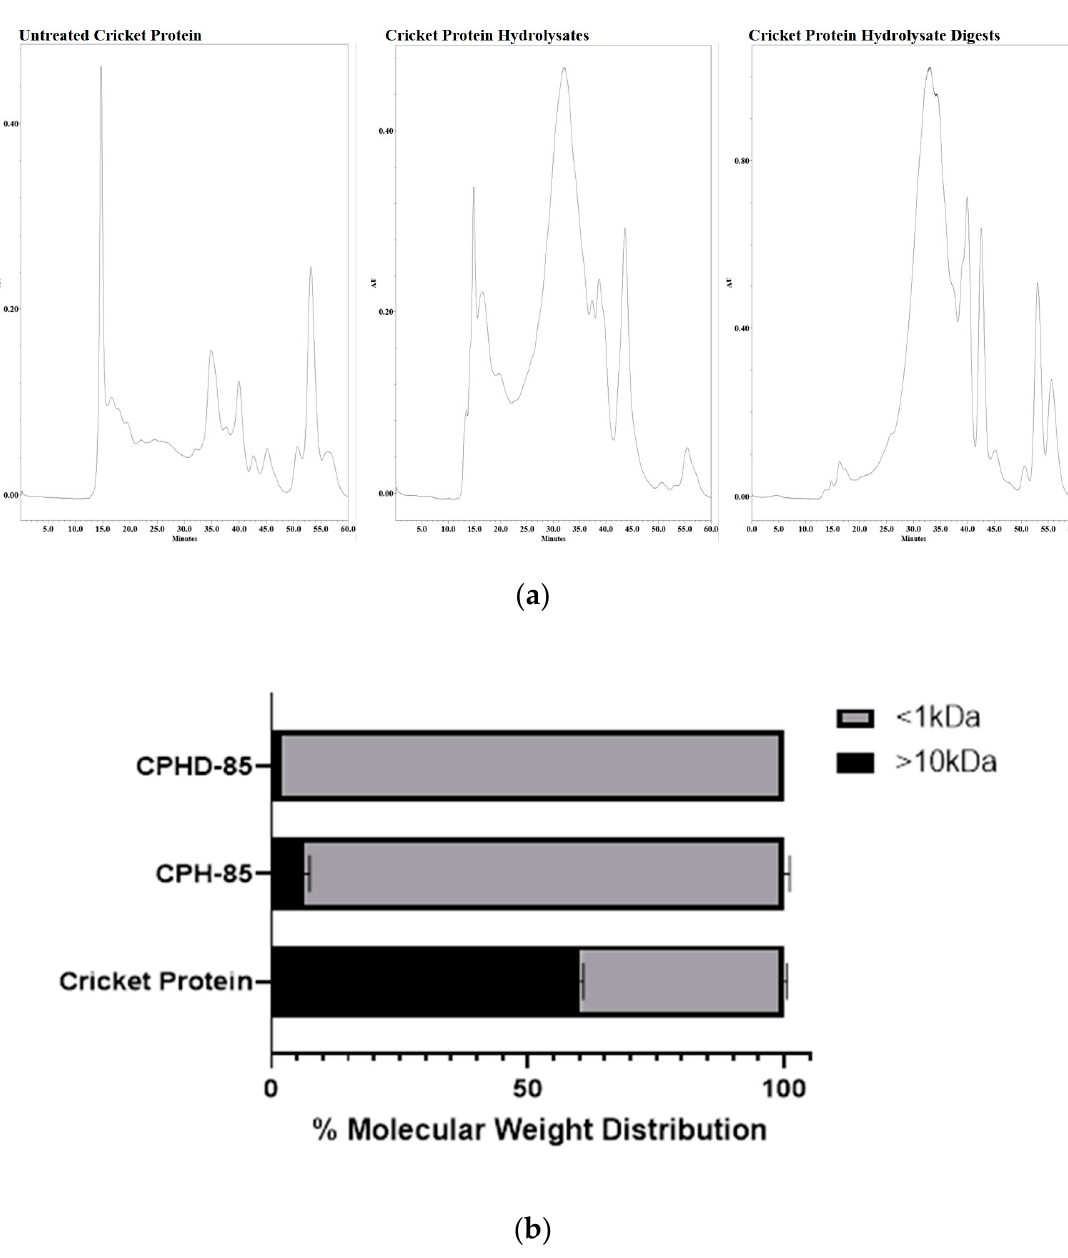
Figure 1. Molecular weight distribution of cricket protein after enzymatic hydrolysis and in vitro digestion. ( a ) Gel filtration peptide profile of non-hydrolyzed cricket protein, cricket protein hydrolyzed with alcalase, and cricket protein hydrolysates (CPH), after digestion with gastrointestinal enzymes. ( b ) Gel filtration peptide profile of non-hydrolyzed cricket protein, cricket protein hydrolyzed with alcalase, and CPH, after digestion with gastrointestinal enzymes.